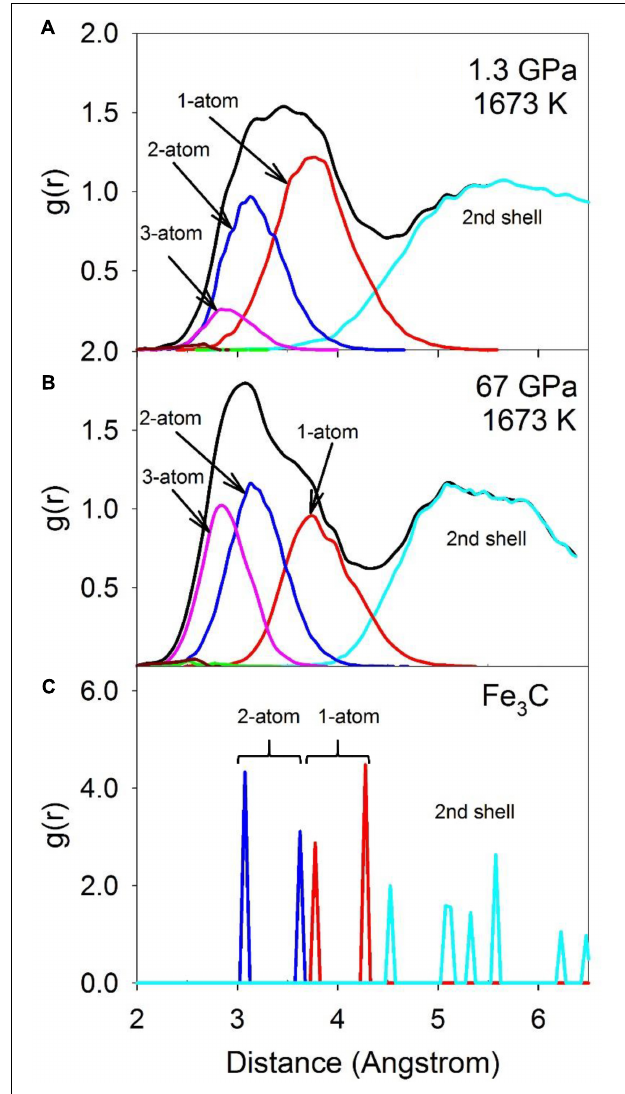
FIGURE 7 | The total RDF (black) and partial configurationally decomposed RDFs of coordination polyhedra of C-Fe/Ni with different connection schemes: 1-atom corner-shared (red), 2-atom edge-shared (blue), 3-atom face-shared (magenta), and 4-atom distorted face-shared (green) connections. (A) Fe-Ni-C liquid at 1.3 GPa, 1673 K, (B) at 67 GPa, 1673 K, and (C) Fe 3 C at ambient